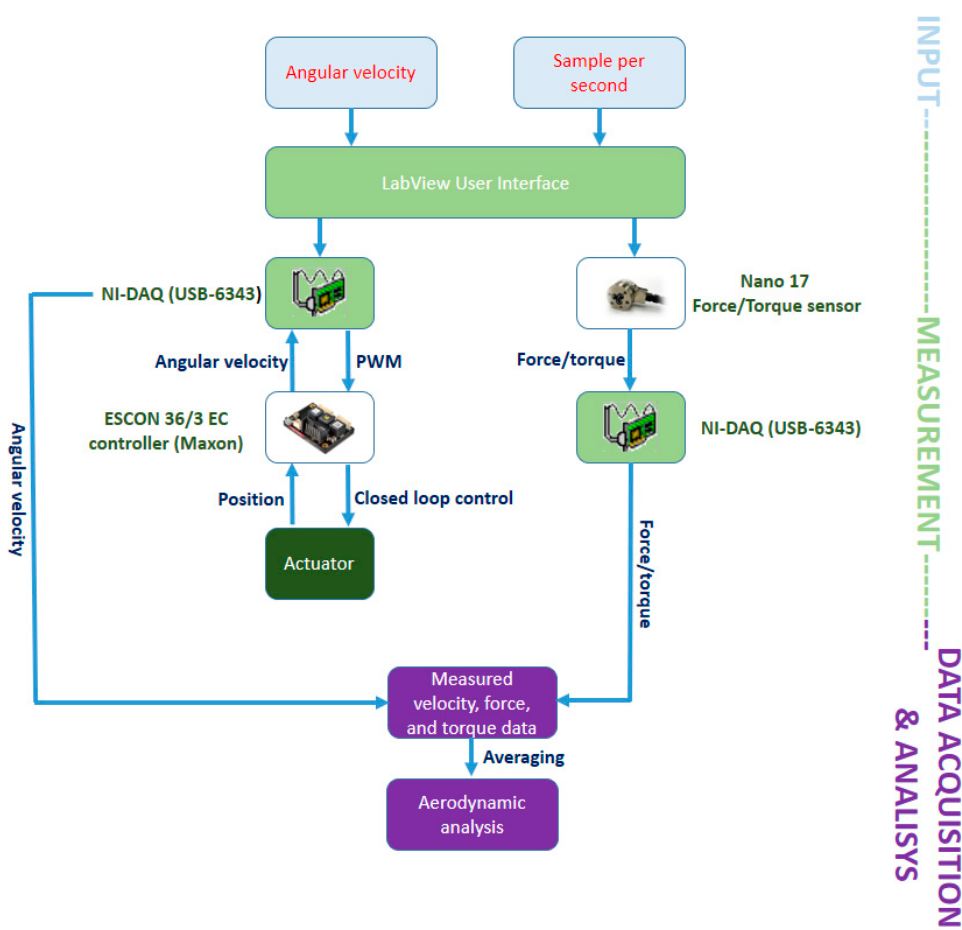
Figure 3. Data acquisition block diagram to measure force and torque of a blade, adapted from